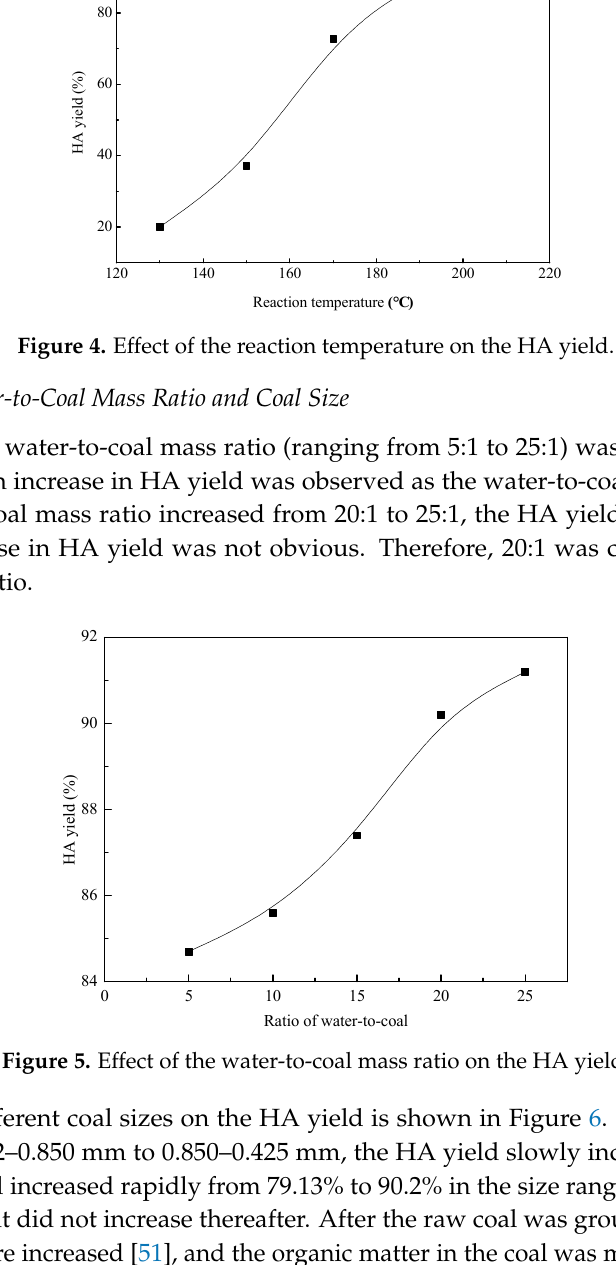
Figure 4. Effect of the reaction temperature on the HA yield.